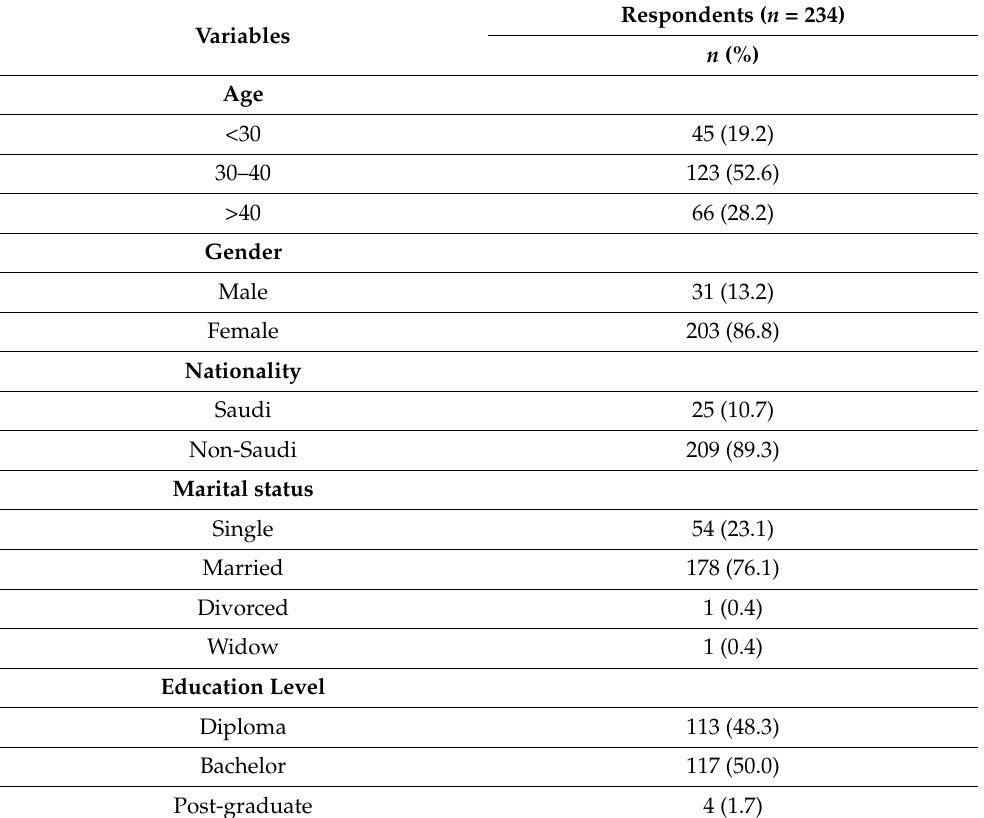
Table 1. Sociodemographic Characteristics of the